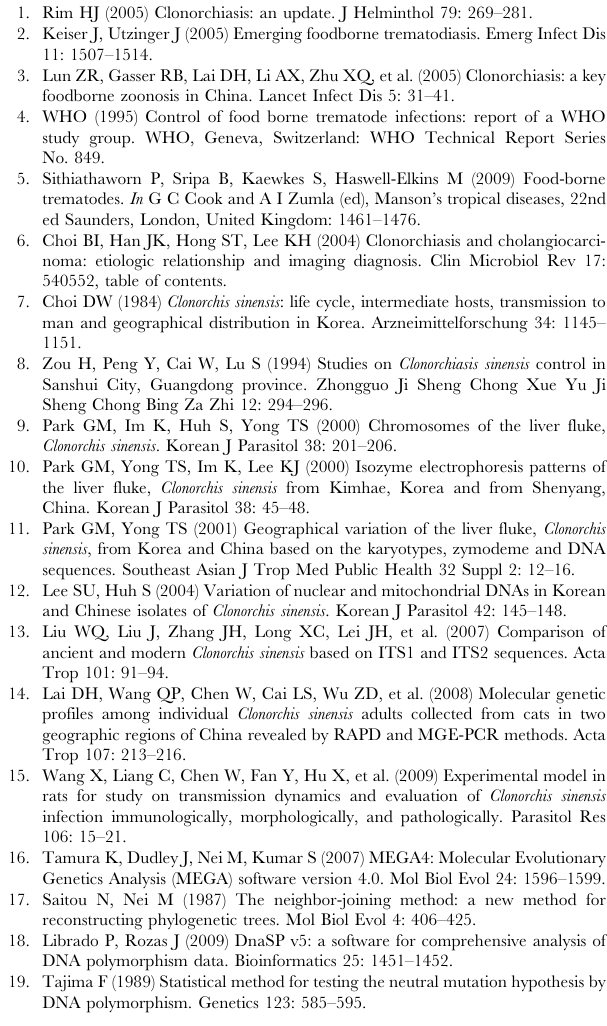
Figure S1 Electrophoresis analysis of partial results of PCR amplification in twelve genes using the primer sets in this study.